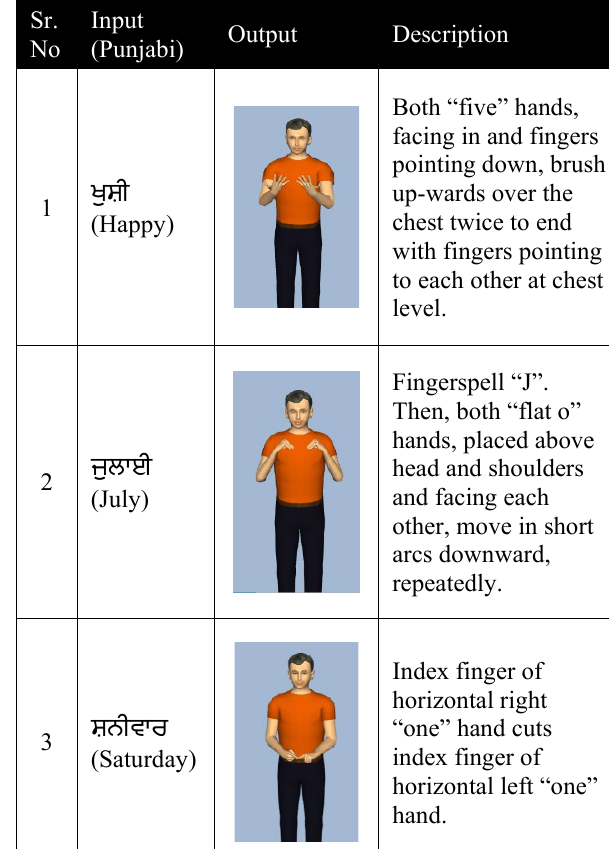
Table 2. Punjabi words, Indian Sign Language and their